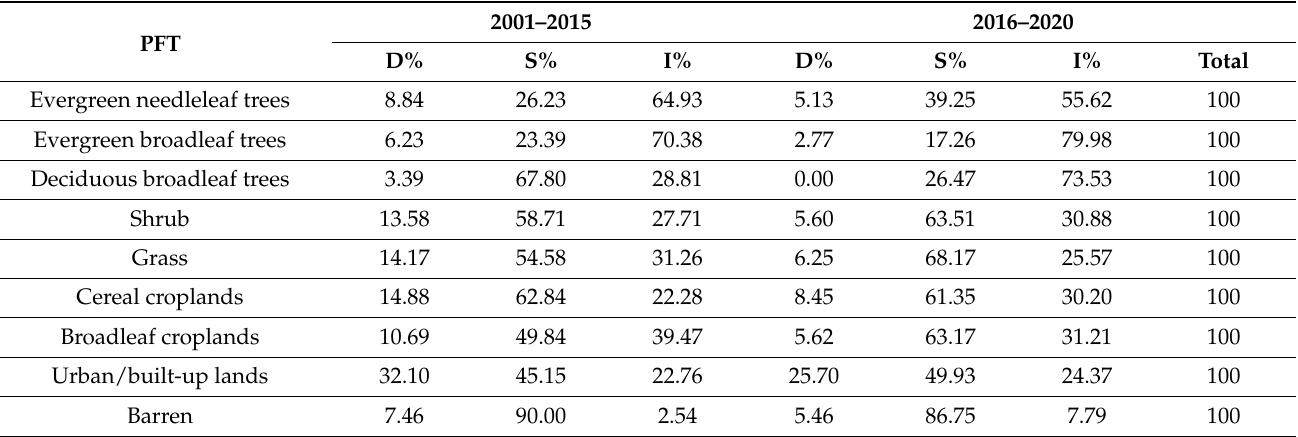
Table 8. Analysis of the land degradation status for each plant functional type in Tunisia for the baseline and the reporting periods (D: Degraded, S: Stable, I: